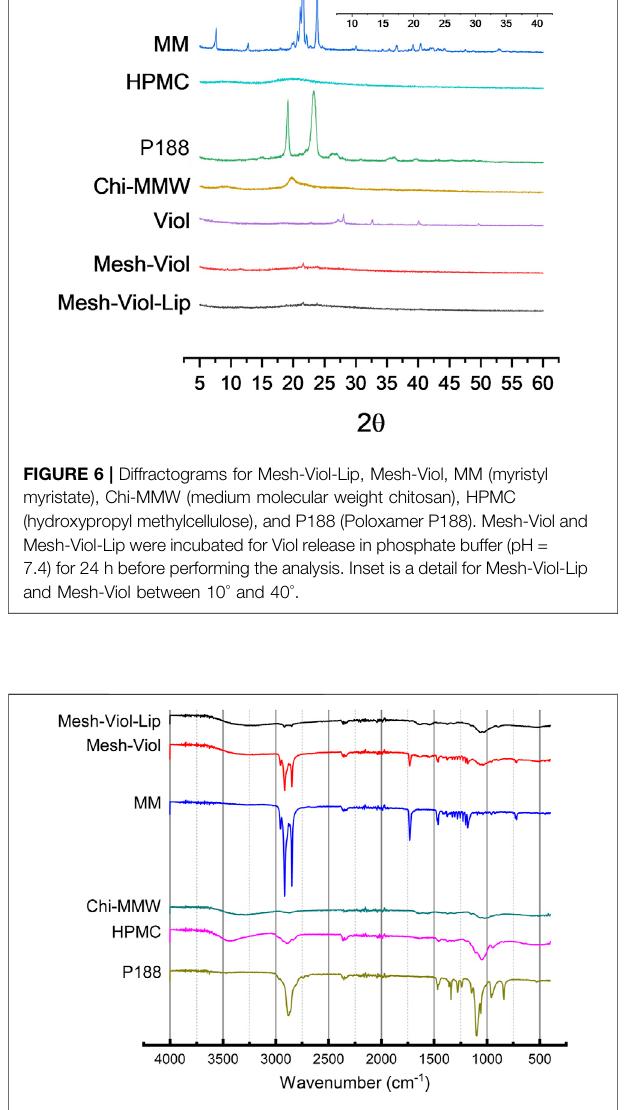
FIGURE 7 | FTIR spectra for Mesh-Viol-Lip, Mesh-Viol, MM (myristyl myristate), Chi-MMW (medium molecular weight chitosan), HPMC (hydroxypropyl methylcellulose), and P188 (Poloxamer P188). Mesh-Viol and Mesh-Viol-Lip were incubated inreleasebuffer (pH =7.4)for 24 hbefore performing the analysis.